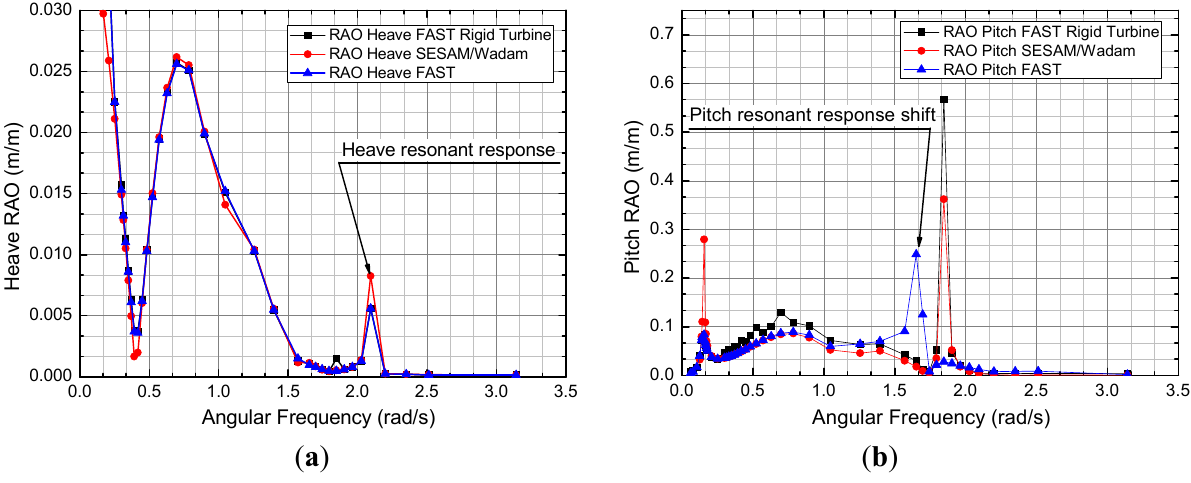
Figure 11. WindStar TLP RAOs: ( a ) Heave response; ( b ) Pitch